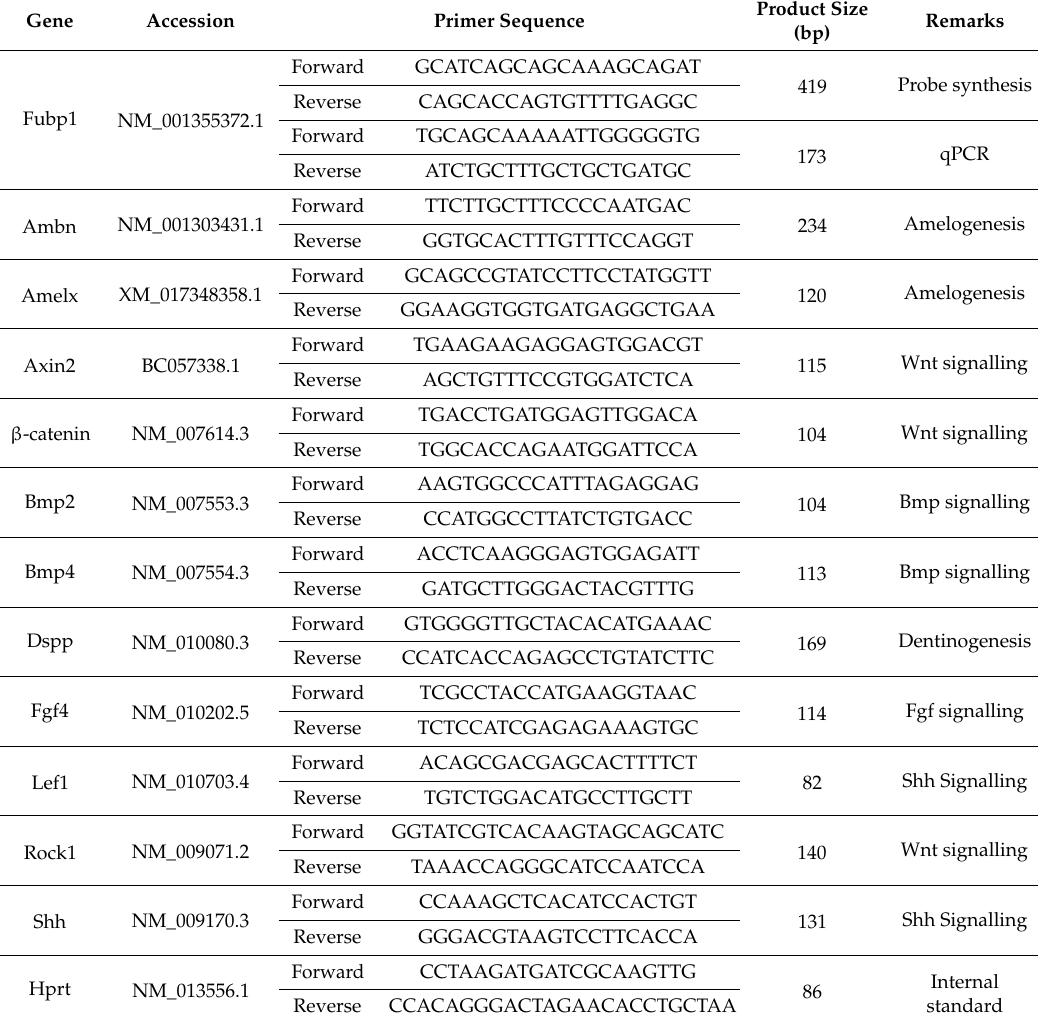
Table 1. List of primers used in the